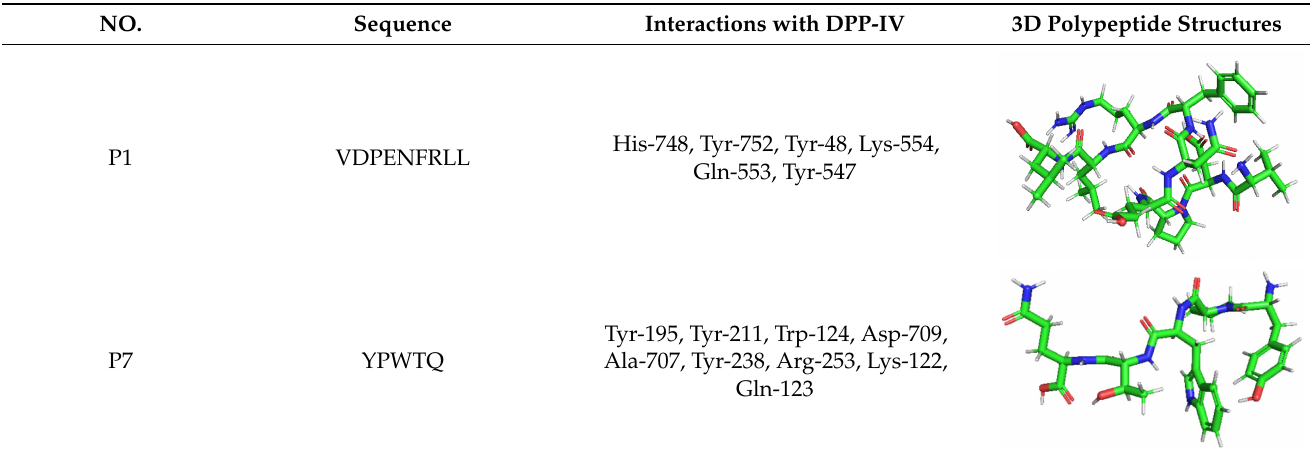
Table 5. Molecular formulae and three-dimensional (3D) polypeptide